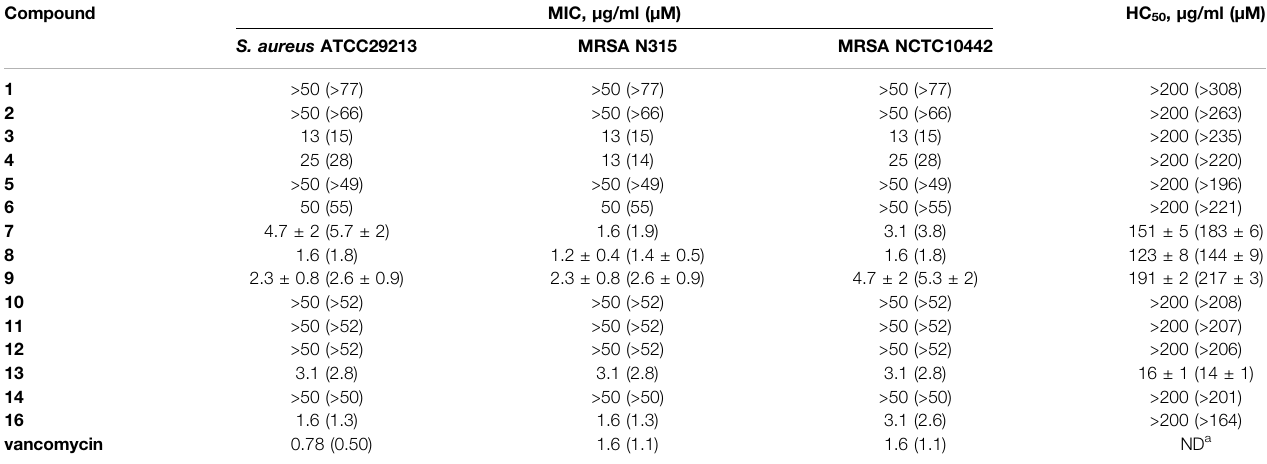
TABLE 1 | In vitro anti-Gram-positive bacterial activities and hemolytic activities of calix[4]arene derivatives 1 – 16. Compound MIC, µg/ml (µM) HC 50 , µg/ml (µM) S. aureus